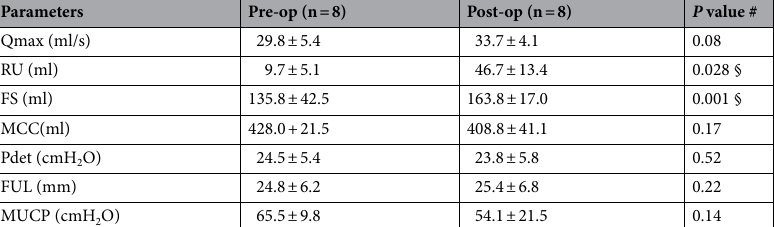
Table 4. Urodynamic changes before and 6 months after PRP treatment. Data are given as n(%) or mean ± standard deviation. PRP, platelet-rich plasma; DO, detrusor overactivity; Qmax, maximum flow rate; RU, residual urine; FS, first sensation to void; MCC, maximum cystometric capacity; Pdet, detrusor pressure at peak flow; FUL, functional urethral length; MUCP, maximum urethral closure pressure. # Paired t-test; § significant